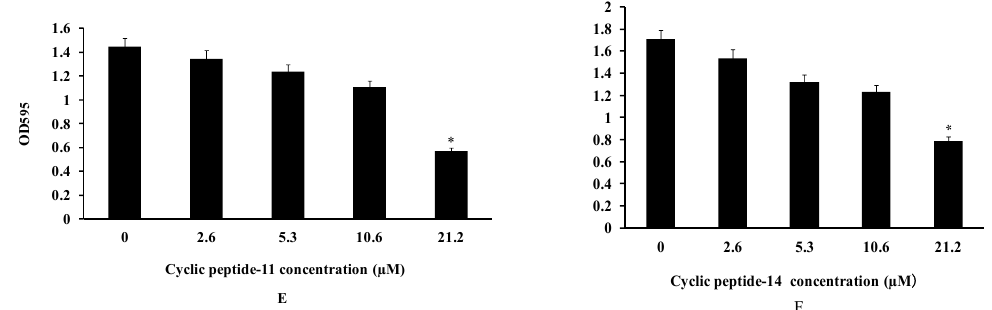
Figure 2. Cyclic peptide-1 ( A ), cyclic peptide-11 ( B ), and cyclic peptide-14 ( C ) prevent biofilm formation. Cyclic peptide-1 ( D ), cyclic peptide-11 ( E ), and cyclic peptide-14 ( F ) disperse established biofilms. A t test was used to determine the statistical significance of biofilms treated at 21.2 μ M versus untreated conditions (* p < 0.0.5).